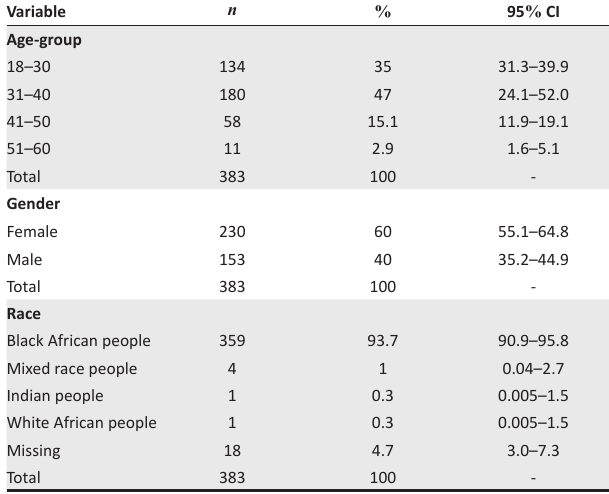
TABLE 1: Demographic profile of all